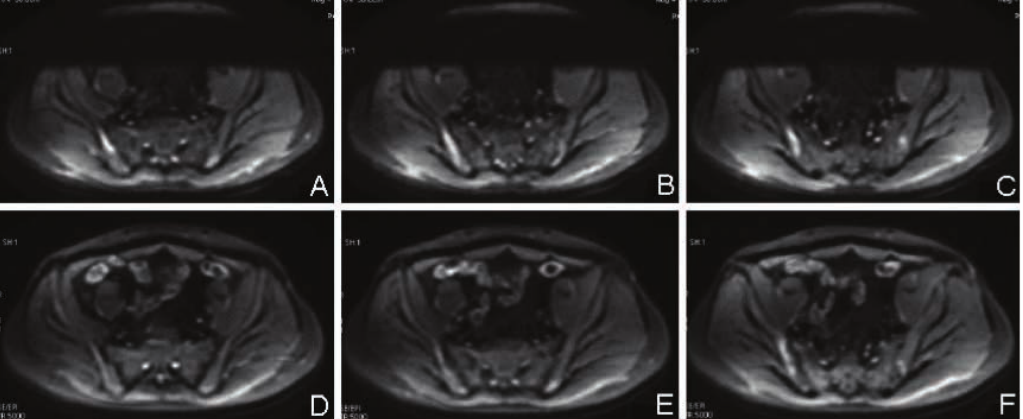
Figure 2: Comparison of DWI image in one patient before and after treatment (A, B, C: before treatment; D, E, F: after treatment). DWI image before treatment showed bilateral post-ilium striped diffusion restricted region; after 4 months’ treatment, reexamination showed decrea- sed signal in diffusion restricted region, shrink area and dwindled ADC value, reflecting a good